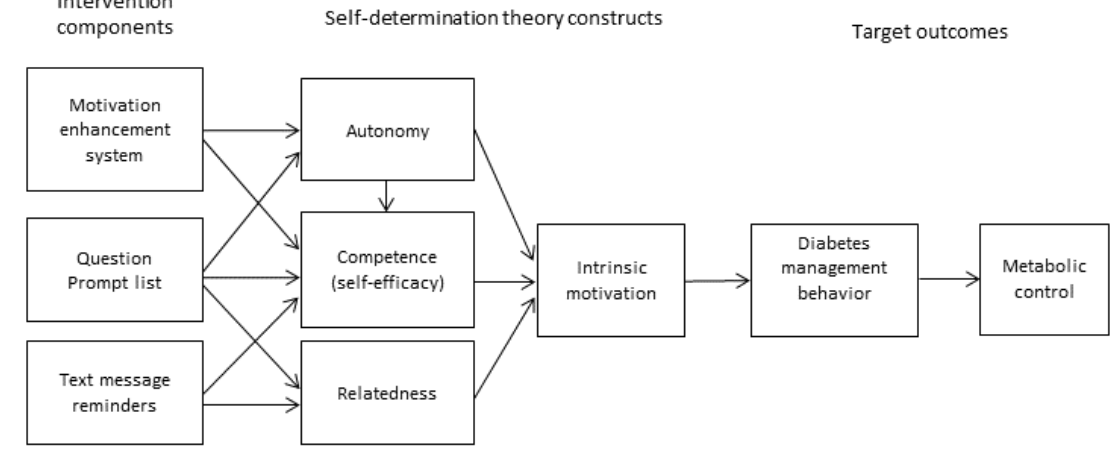
Figure 1. Theoretical model of the proposed intervention